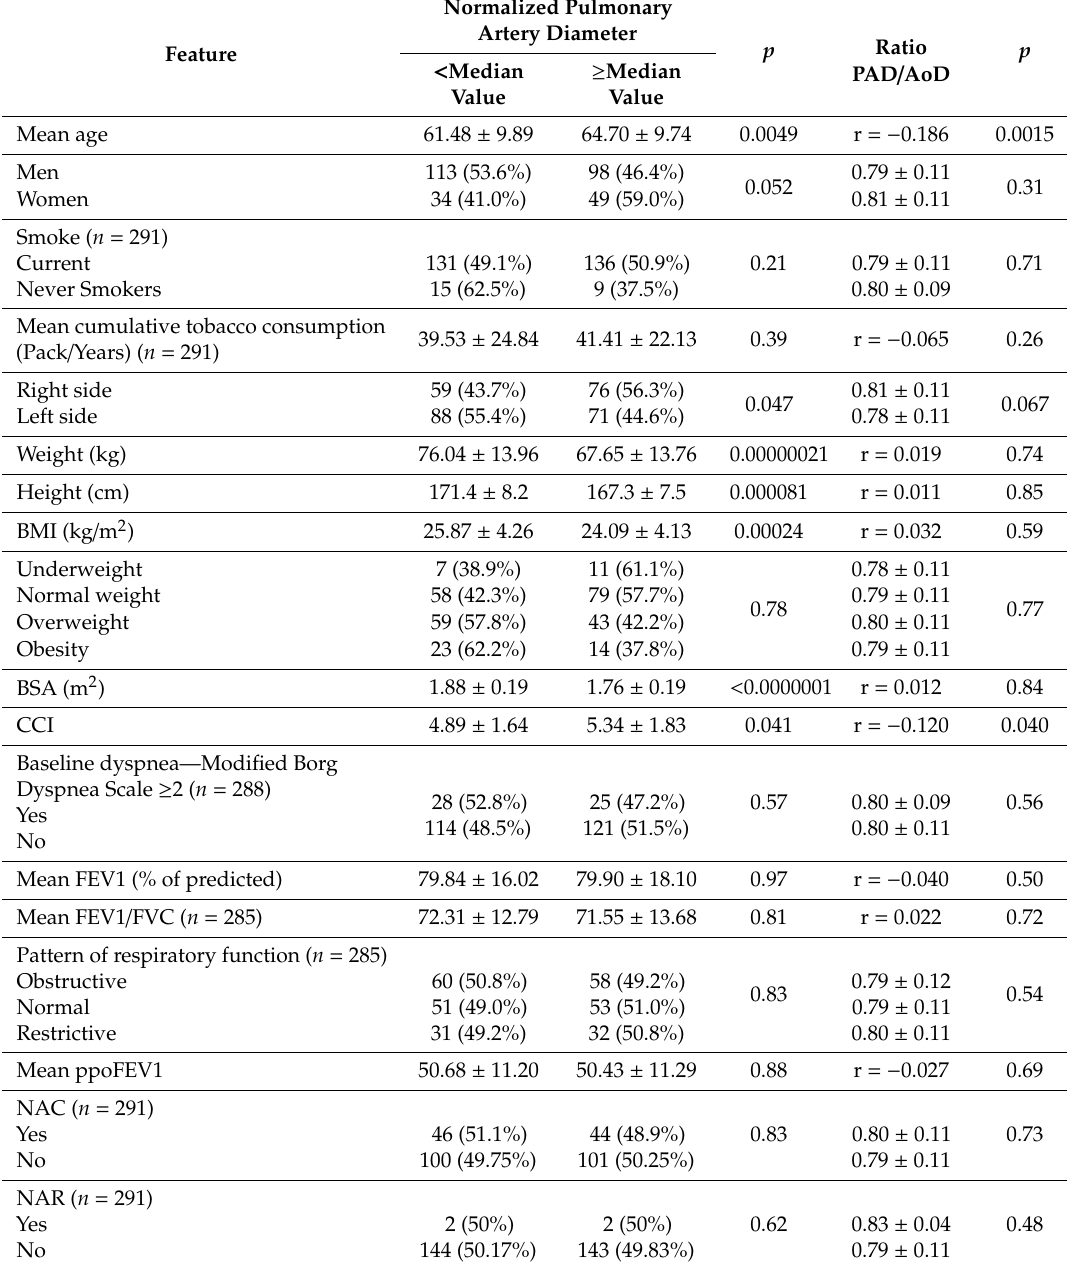
Table 2. Correlations between NPAD and PAD / aorta diameter (AoD) ratio with morphometric, clinical and laboratory